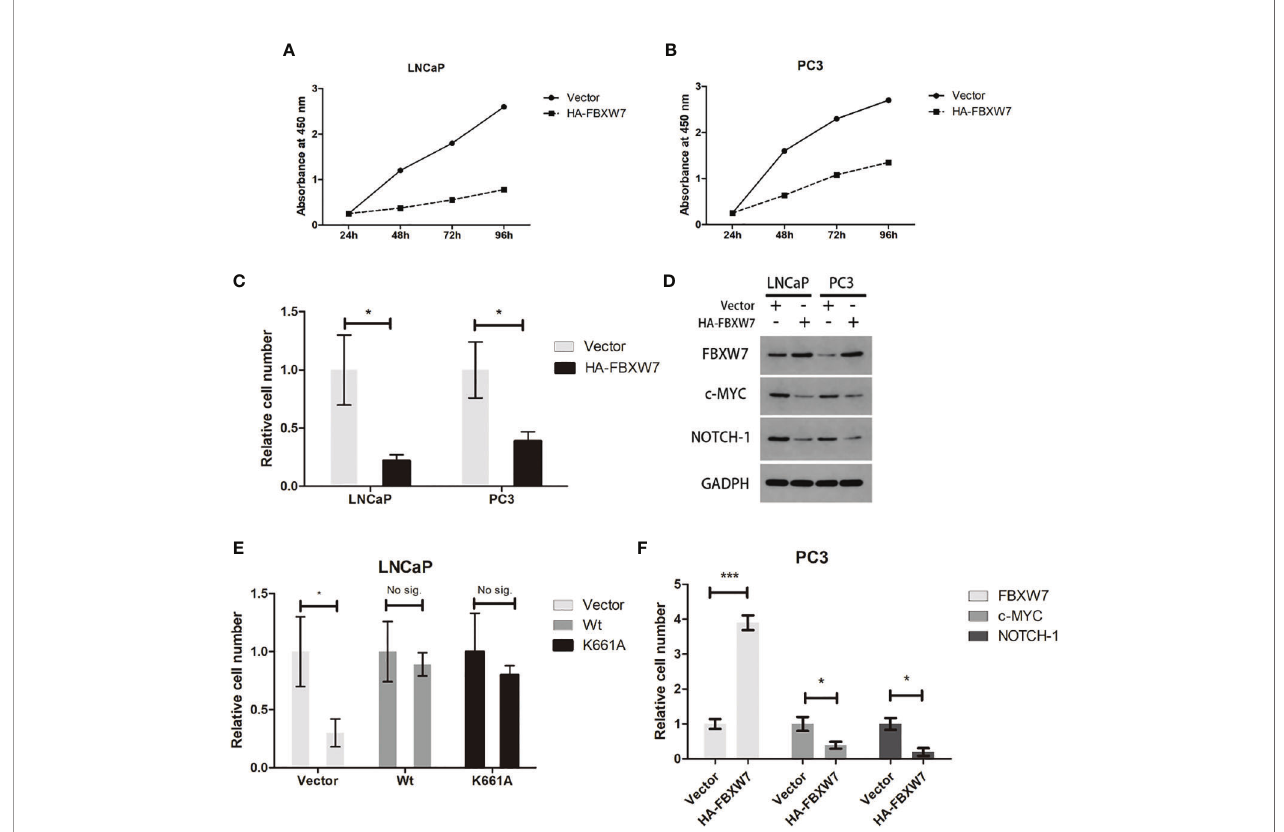
FIGURE 2 | Increasing FBXW7 protein level suppress PCa cell viability by inhibiting key human cancer proteins. (A – C) The relative cell number of two cell lines after FBXW7 overexpression by plasmid vectors. (D) The result of immunoblotting performed by indicated antibodies. (E , F) The change of relative expression level of each protein compared by control group. Values are expressed as the mean ± SEM.*P < 0.05, ***P<0.001, n = 3, relative to the vector group. Protein levels were normalized by